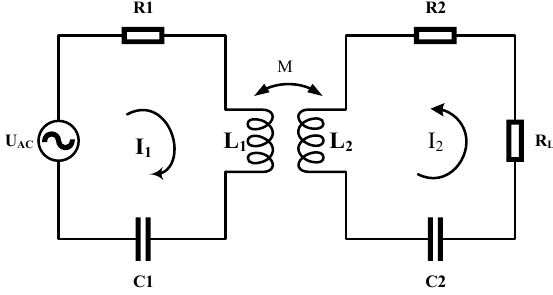
Figure 2. Magnetically coupled resonant circuit model.